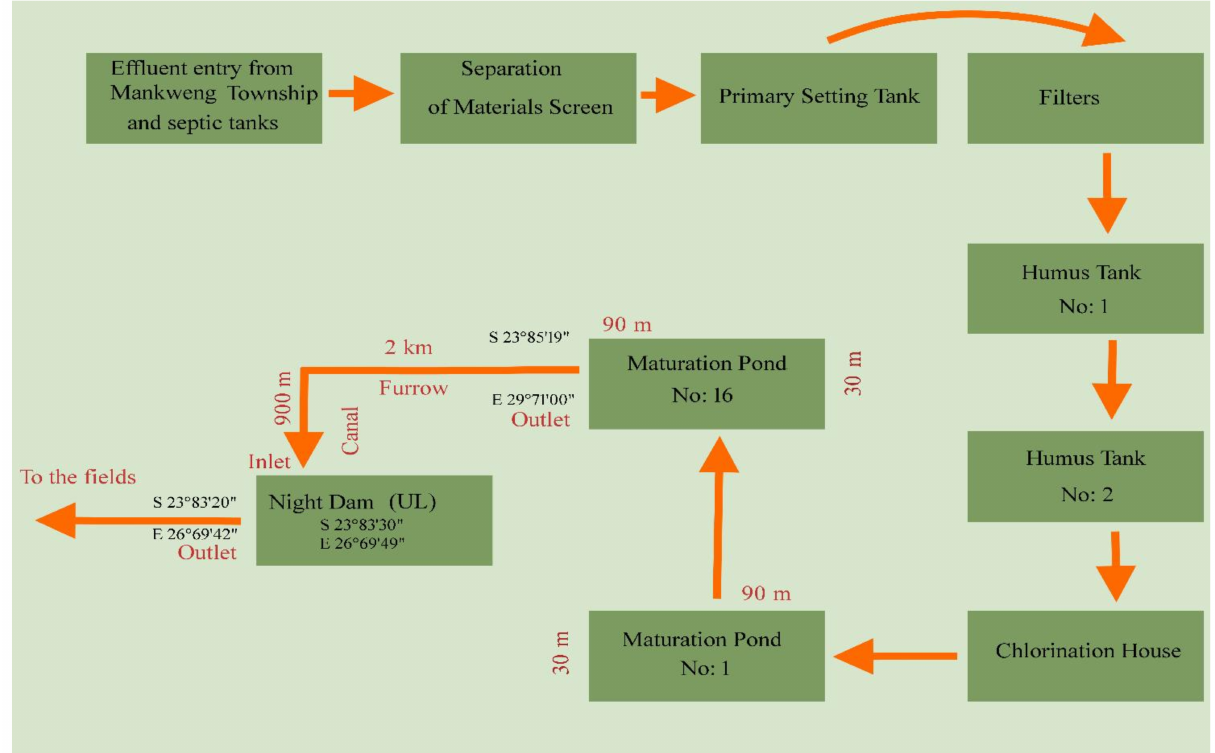
Figure 2. Schematic representation of the sampling points from the Mankweng Wastewater Treatment Plant in Mankweng and the receiving dam at UL Experimental